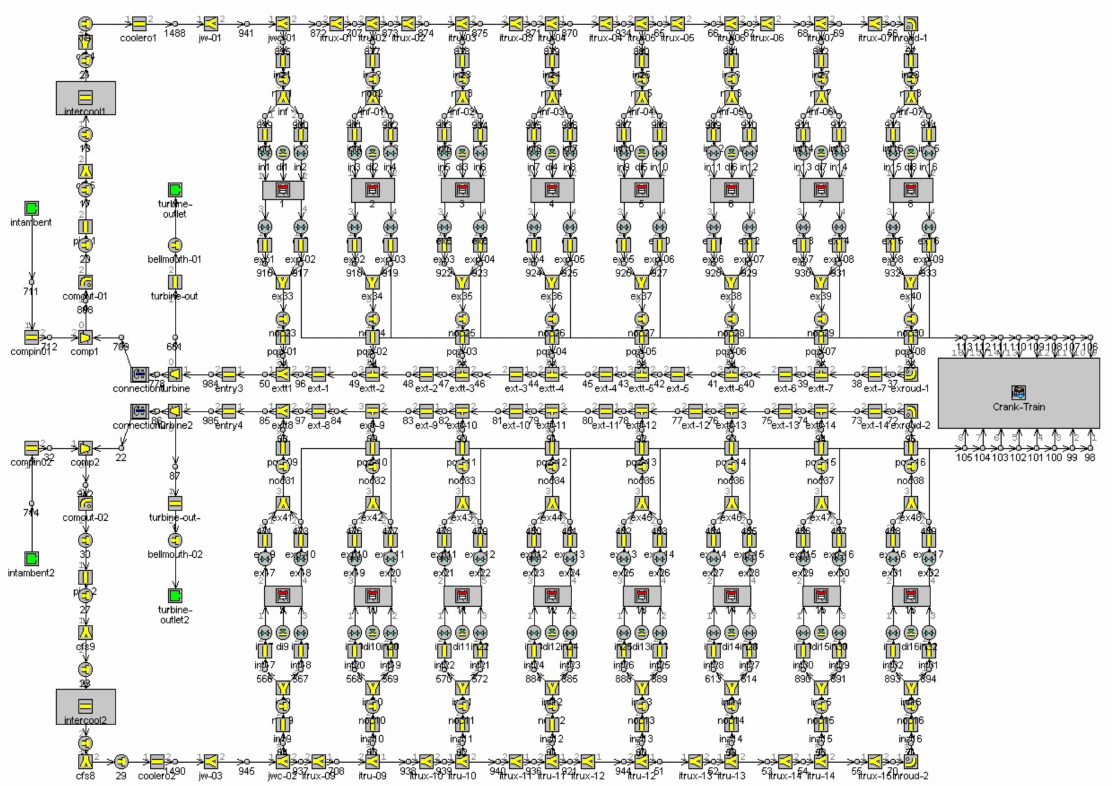
Figure 4. Simulation model of the entire diesel